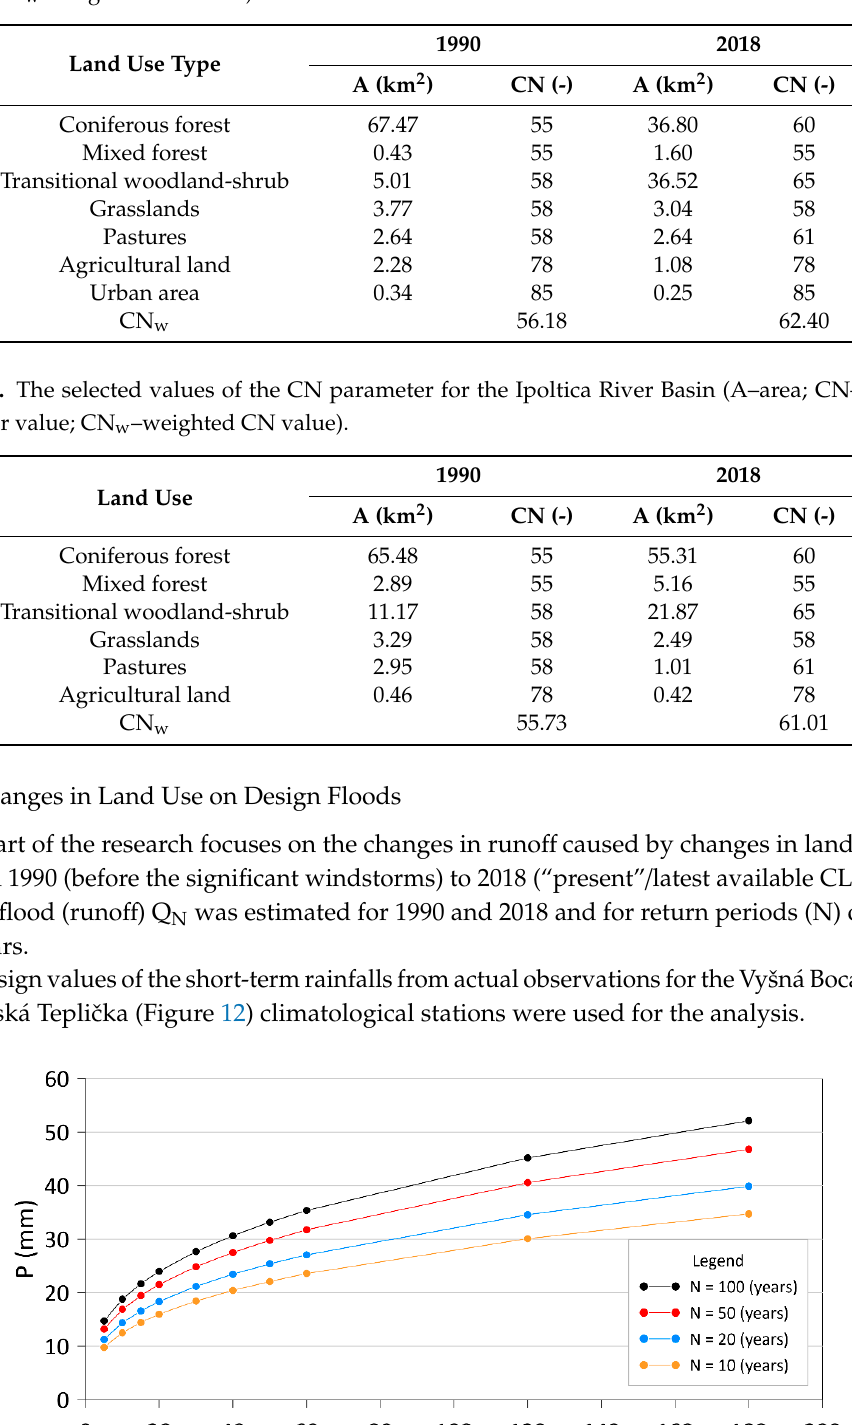
Figure 12. The actual design values of the short-term rainfall for the Liptovska Tepli č ka climatological station. The duration of the design short-term rainfall was selected according to the time of the concentration, which was calculated from the mean runoff velocity along the runoff path (determined according to Alena [53]). The time of concentration and runoff velocity is affected by the slope of the terrain and the land use and land cover along the runoff´s path. In the case of the Boca River basin, the land use along the path has changed significantly over time; hence, the time of concentration/duration for 1990 (80 min) is different than that for 2018 (69 min). In the case of the Ipoltica River, the duration of the design short-term rainfall was determined to be equal to 84 min for 1990 and 2018. Rainfall intensities for the 1941–1944 period from the Vyšná Boca climatological station were used for the estimation of the design flood in the Boca River basin. The data from the Liptovská Tepli č ka climatological station consists of rainfall intensities for the 1995–2009 period and were used for the estimation of the design floods in the Ipoltica River basin. The calculations and results of the design floods in the Boca River basin estimation using the design values of the short-term rainfall for the Vyšná Boca climatological station for the actual period are shown in Table 10.